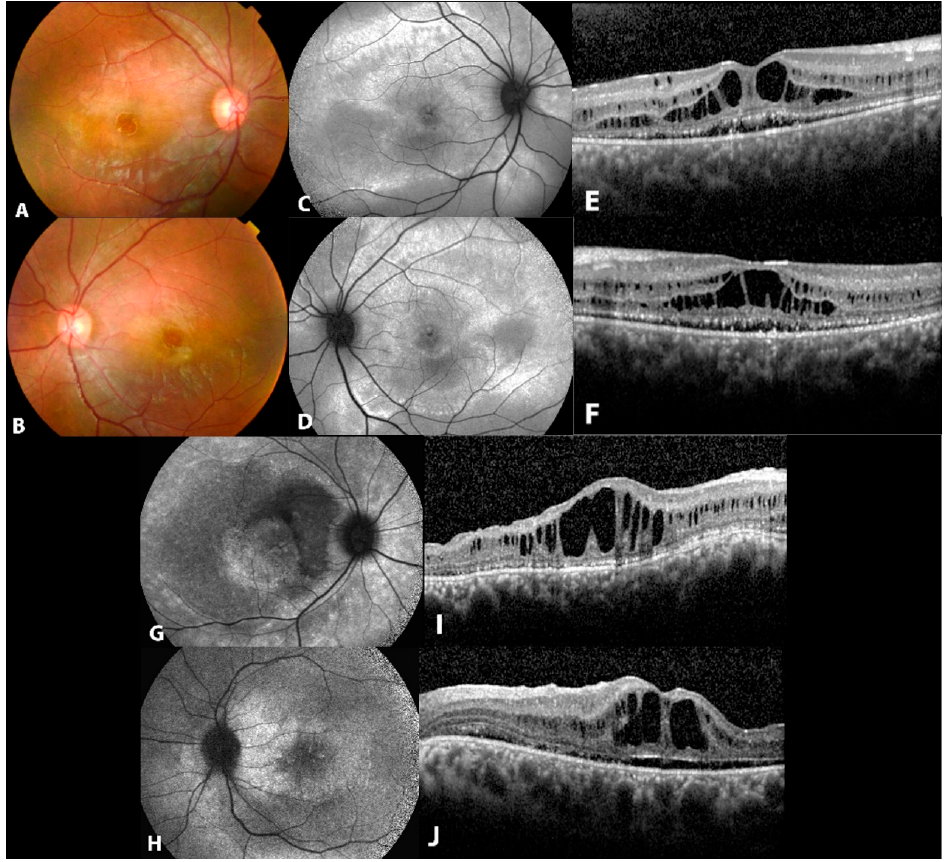
Figure 4. Clinical and imaging features of patients from family F. ( A , B ) Fundus photographs of both eyes of propositus (II.1) from family F showing macular vitelliform lesions. ( C , D ) Autofluorescence image of both eyes showing hyper autofluorescent areas in the posterior pole and along the vascular arcades. ( E , F ) OCT with subretinal fluid, macular schisis and diffuse choroidal thickening. ( G , H ) fundus autofluorescence in both eyes of patient (II.2) showing areas of hyperautofluroescence ( I , J ) OCT with subfoveal schisis, as well as subretinal detachment and diffuse choroidal thickening.